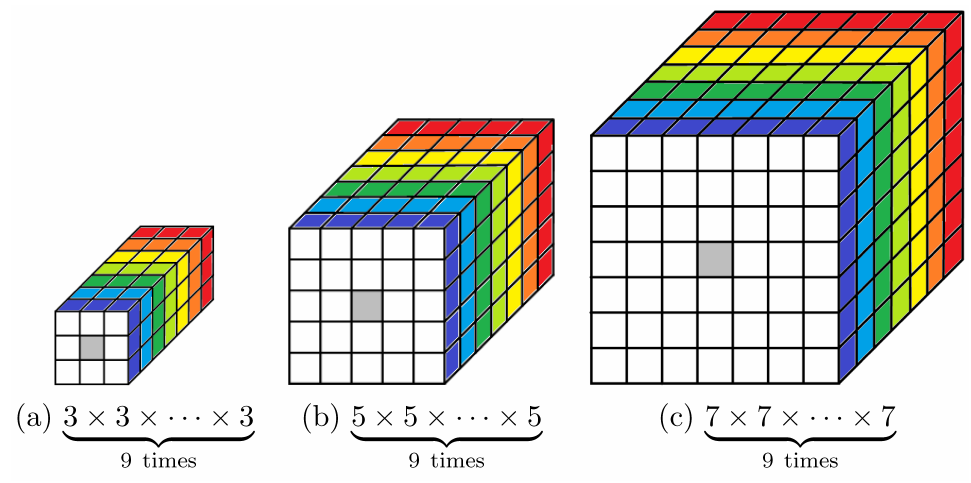
Figure 8. The analysis boxes for sizes δ = 3, δ = 5, and δ = 7.